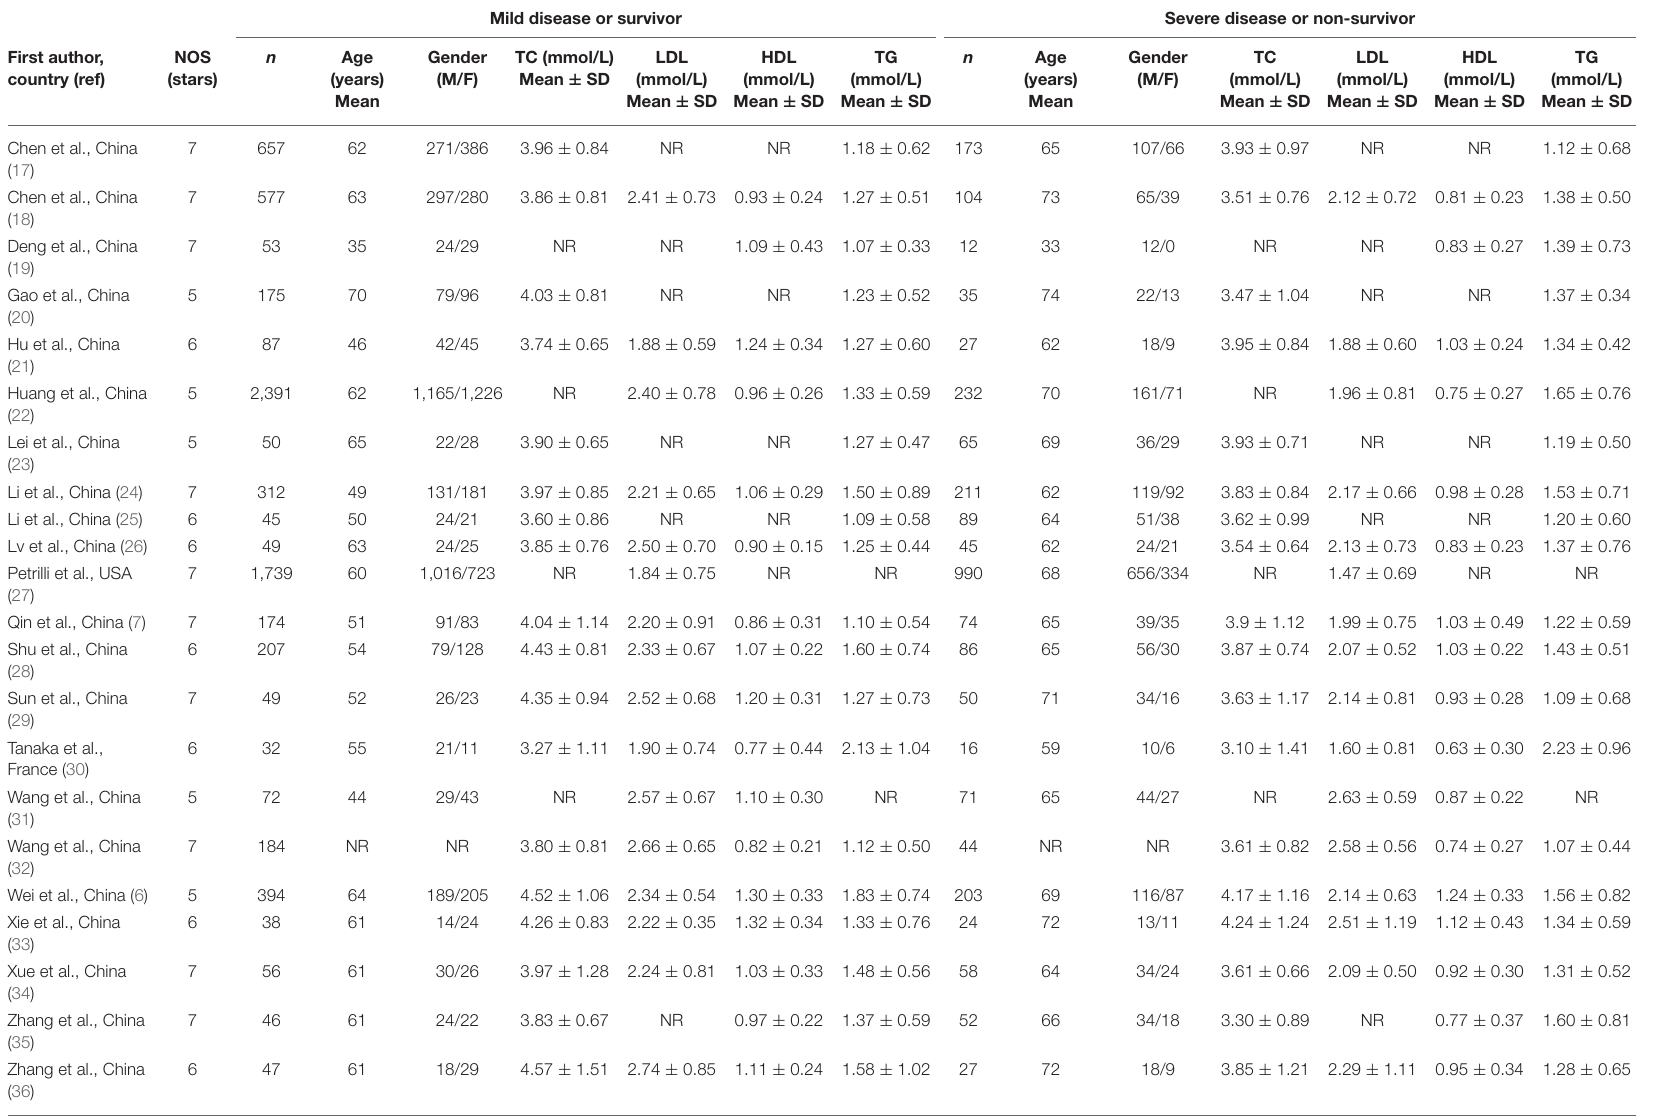
TABLE 1 | Characteristics of the studies in COVID-19 patients, according to disease severity or survival status, included in the